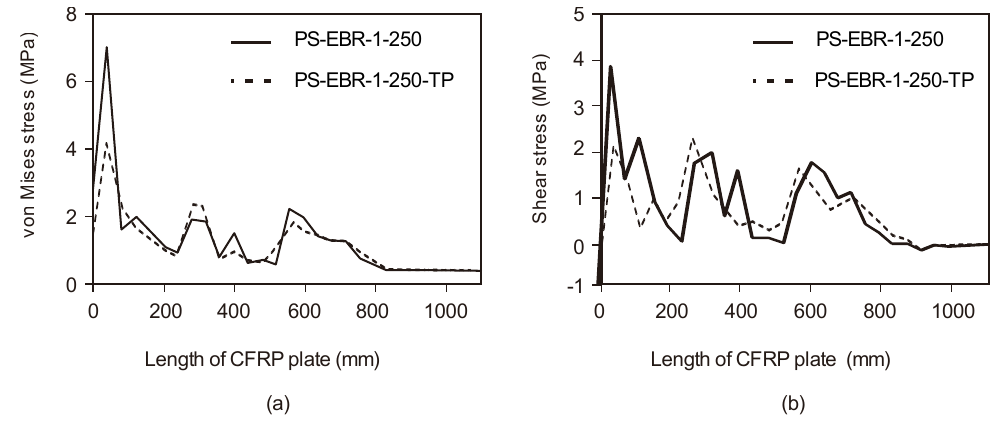
Figure 11. CFRP-concrete interfacial stress ( a ) principal stress and ( b ) shear stress.